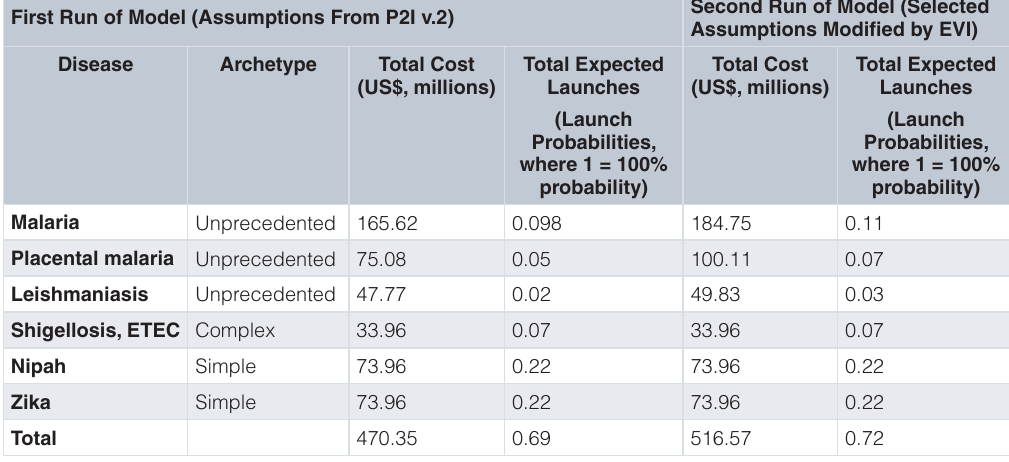
Table 7. Comparison of model outputs based on original assumptions and EVI assumptions. First Run of Model (Assumptions From P2I v.2)